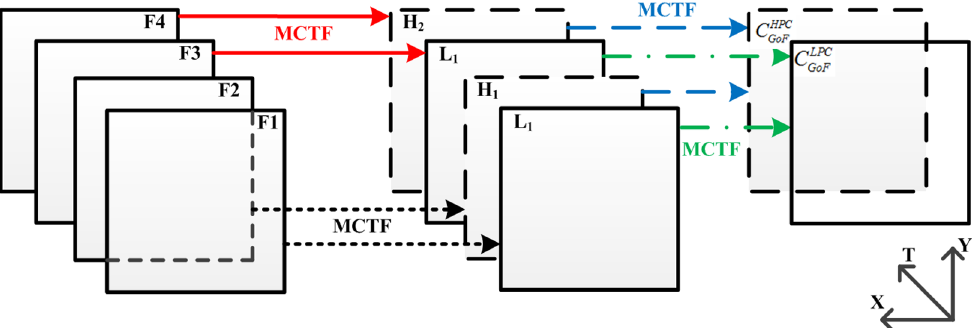
Fig 2. MCTF procedure in a four-frame GoF. Different levels of MCTF are separated by colors and line